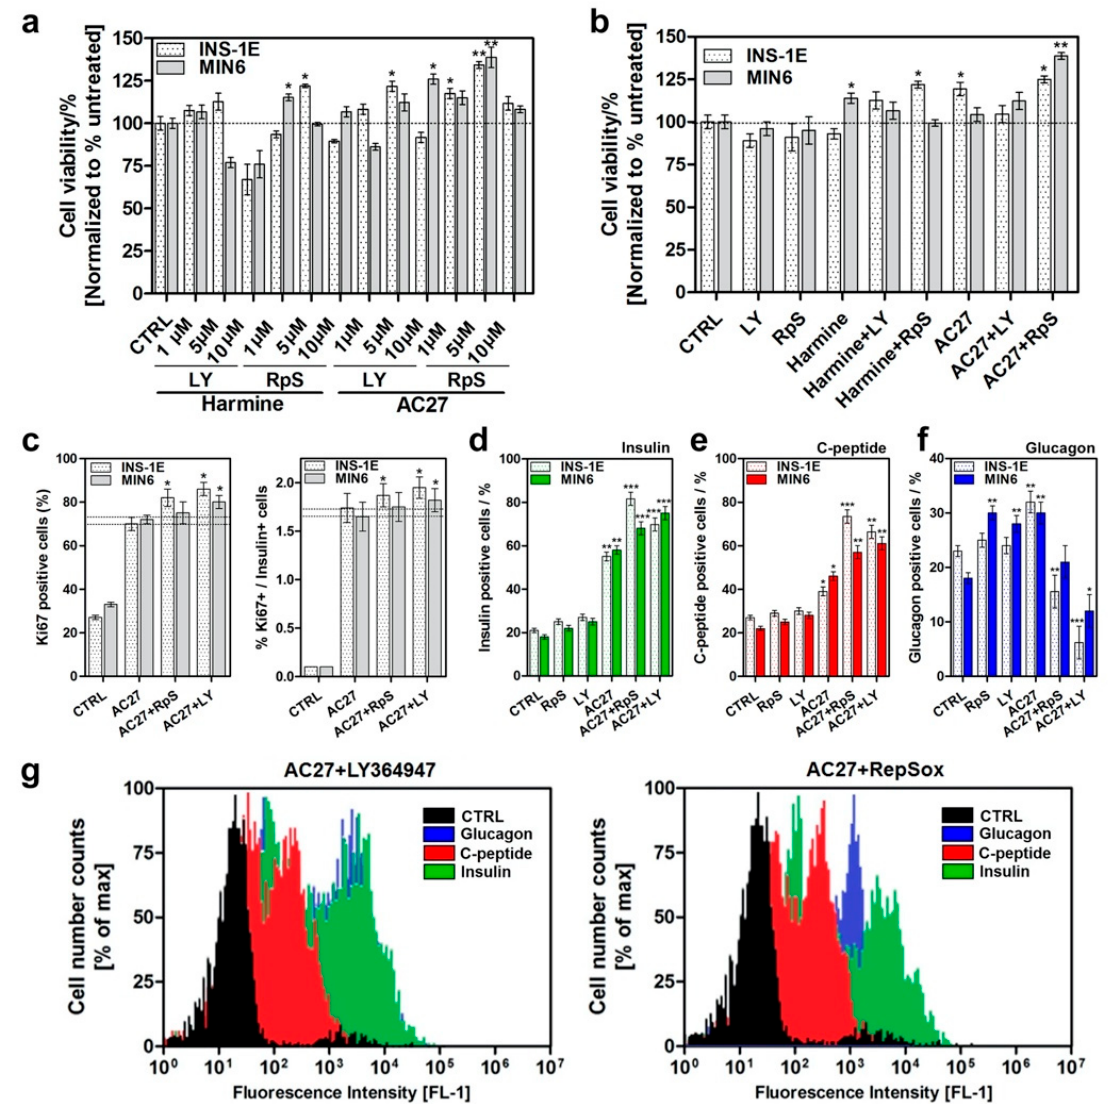
Figure 9. Effects of the AC27-TGF- β combination on INS-1E and MIN6 cells. ( a ) Viability of MIN6 and INS-1E cell lines after treatment with the harmine-TGF- β inhibitor and AC27-TGF- β inhibitor combination. The concentration of TGF- β inhibitors used was 1 µ M, 5 µ M or 10 µ M. The concentration of DYRK1A inhibitors used was 5 µ M. Viability (after 24 h) of MIN6 and INS-1E cell lines after treatment with a combination of harmine-TGF- β inhibitor and AC27-TGF- β inhibitor and with the use of DYRK1A or TGF- β inhibitors alone. ( b ) Analysis of the influence of the AC27-TGF- β inhibitor combination on the β -cell proliferation: INS-1E and MIN6 proliferation assay using 5 µ M of each compound (DYRK1A and TGF- β inhibitor). ( c ) Effects of the AC27-TGF- β inhibitor combination on Ki67 immunolabeling in MIN6 and INS-1E cell lines. ( d ) Effects of the AC27-TGF- β inhibitor combination on insulin immunostaining in MIN6 and INS-1E cell lines. ( e ) Effects of the AC27-TGF- β inhibitor combination on the C-peptide immunostaining in MIN6 and INS-1E cell lines. ( f ) Effects of the AC27-TGF- β inhibitor combination on glucagon immunostaining in MIN6 and INS-1E cell lines. ( g ) Representative flow cytometry profiles from analysis summarized in panels ( d – f ) in INS-1E cells. Data are expressed as mean ± SEM. * p < 0.05, ** p < 0.01; *** p < 0.001 as compared to the control.